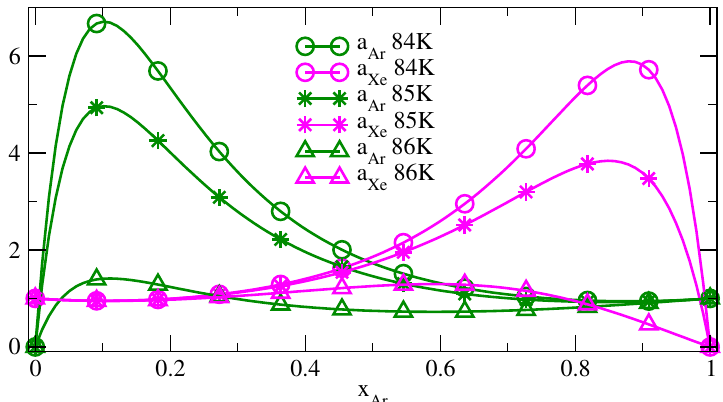
Figure 11. Activity of Ar and Xe as a function of the Ar concentration calculated with the Margules